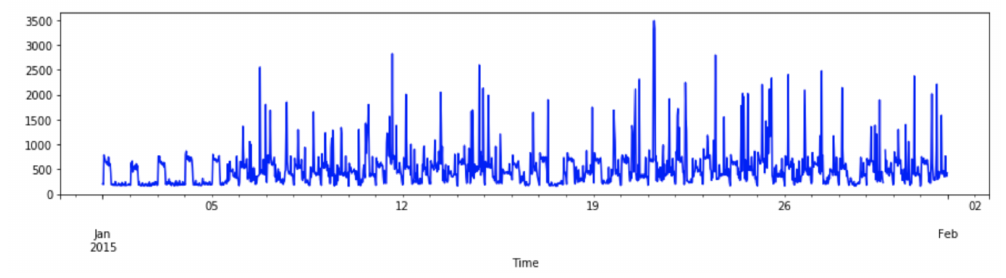
Figure 2. The data representation of one month of energy consumption—January 2015. Table 1. Descriptive statistics for electricity consumption of one month—January 2015.